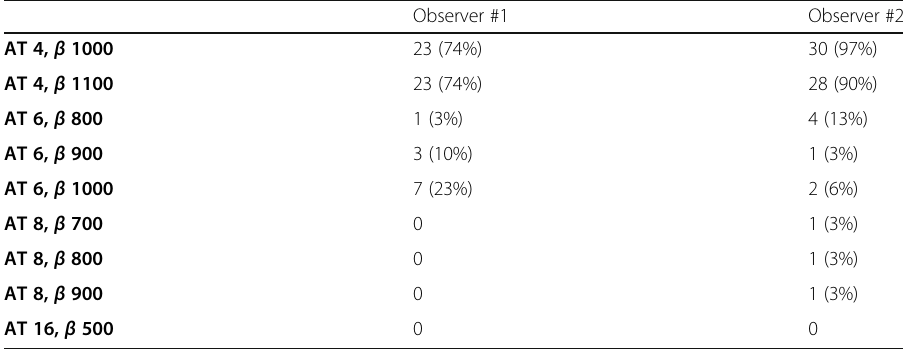
Table 2 Assessment of image quality. The number of patients with unacceptable image quality in [ 18 F]PSMA-1007 PET-CT examinations assessed by two observers